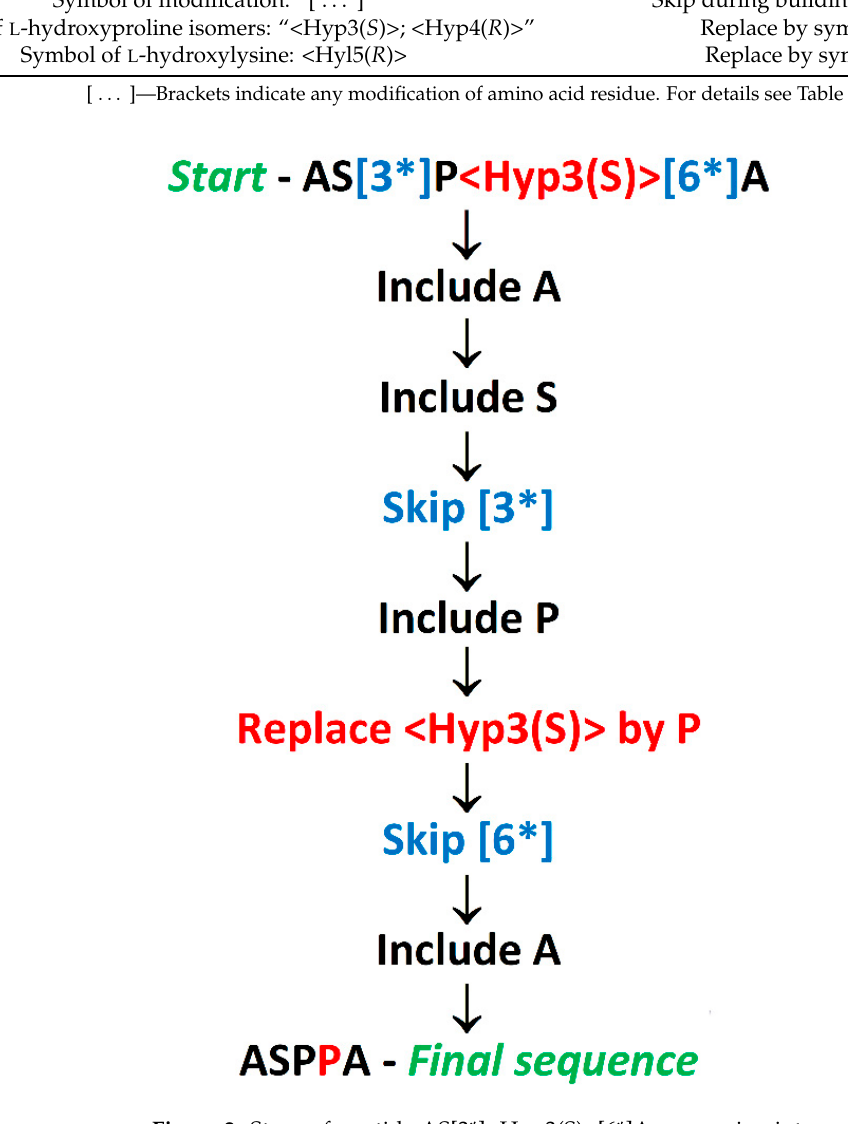
Table 5. Conversion of a modified peptide representation into an unmodified sequence consisting of proteinogenic amino acids. Symbol Operation One-letter symbol of proteinogenic amino acid Include into unmodified sequence.